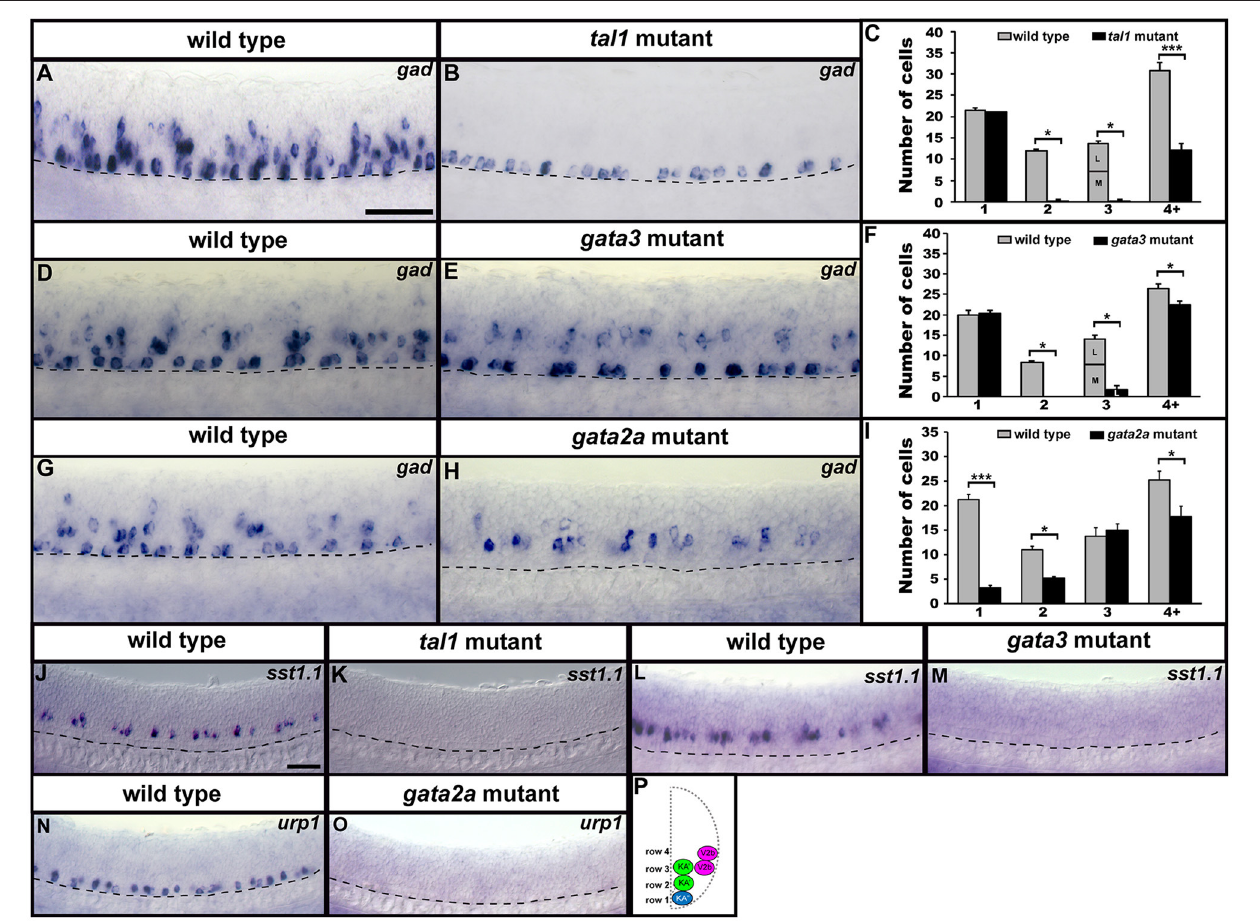
FIGURE 7 | Neurotransmitter and neuropeptide phenotypes in tal1 , gata3, and gata2a mutants. Lateral views of gad , sst1.1, and urp1 expression in 24h WT sibling (A,D,G,J,L,N) and tal1 (B,K) , gata3 (E,M) , and gata2a (H,O) mutants. Dorsal, top; anterior, left. Cross-sectional schematic indicating positions of KA ′′ , KA ′ , and V2b neurons (P) . Scale bars (A) = 50 microns (A,B,D,E,G,H) ; (J) = 50 microns (J–O) . Dashed lines indicate ventral limit of spinal cord. Mean number of cells expressing gad in each D/V row of spinal cord region adjacent to somites 6–10 in WT and mutant embryos (C,F,I) . For tal1 and gata3 mutant results (C,F) the approximate proportions of medial and lateral row 3 cells are indicated by horizontal lines separating the number of medially-located cells (bottom and indicated with an “M”) from the number of laterally-located cells (top and indicated with a “L”). All of the remaining row 3 cells in these mutants are lateral, consistent with them being V2b cells. More dorsal (row 4 and above) cells expressing gad in tal1 mutants (B) are only weakly stained and are in a different focal plane to the strongly stained KA ′′ cells, so they are harder to see. All counts are an average of at least 4 embryos. Error bars indicate SEM. Statistically significant comparisons are indicated with brackets and stars. *** P < 0.001, * P < 0.05. For P- values see Supplementary Table 3.